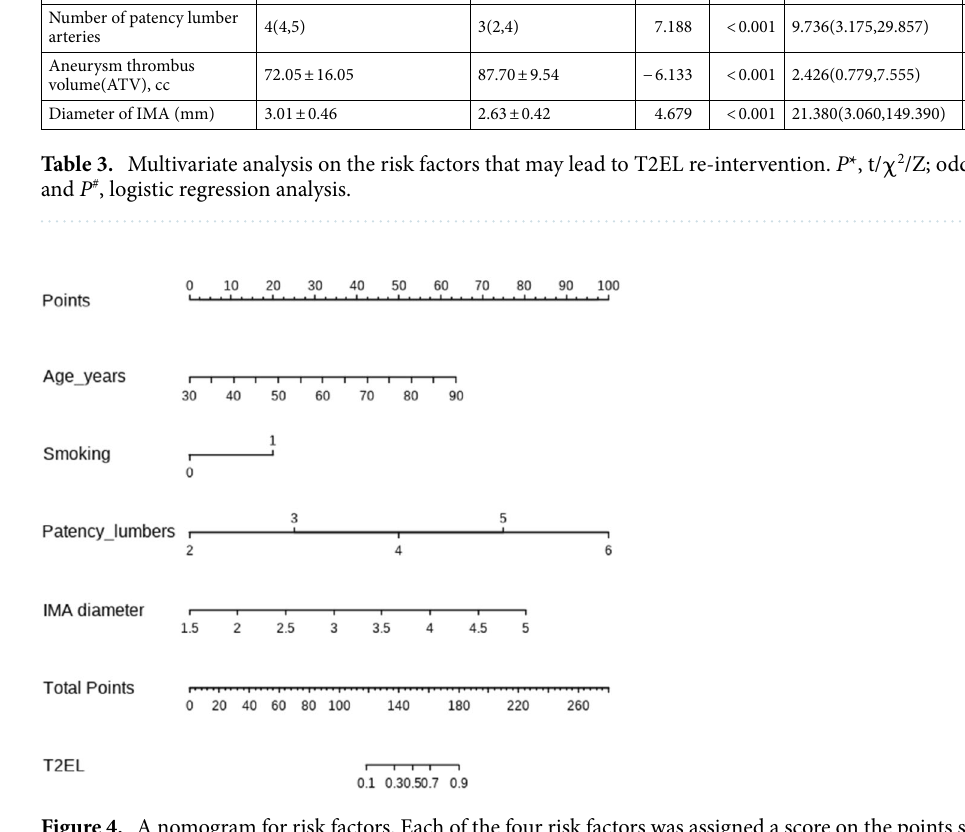
Figure 4. A nomogram for risk factors. Each of the four risk factors was assigned a score on the points scale. After adding each score together and locating the value on the total points scale, a straight line could be drawn downward to determine the estimated risk of adverse